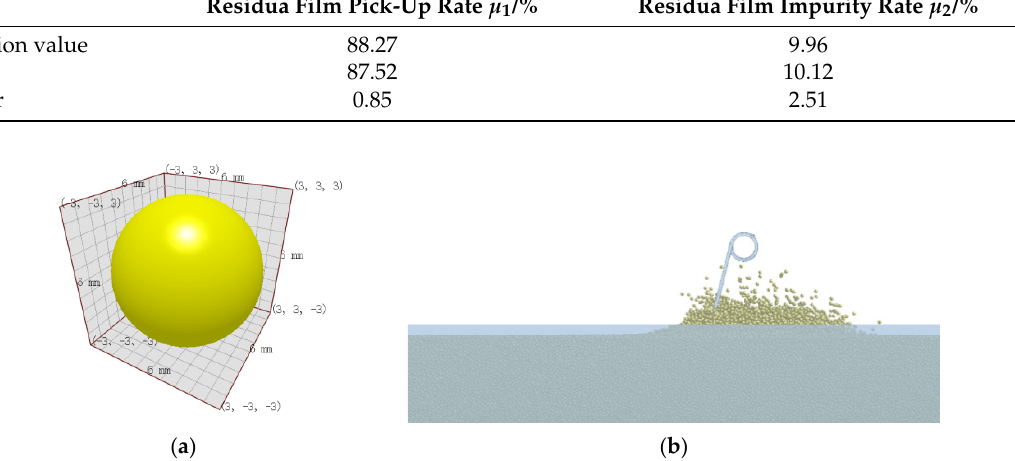
Figure 14. A particle and geometric simulation model. ( a ) Particle model of the soil; ( b ) simulation model of the EDEM.